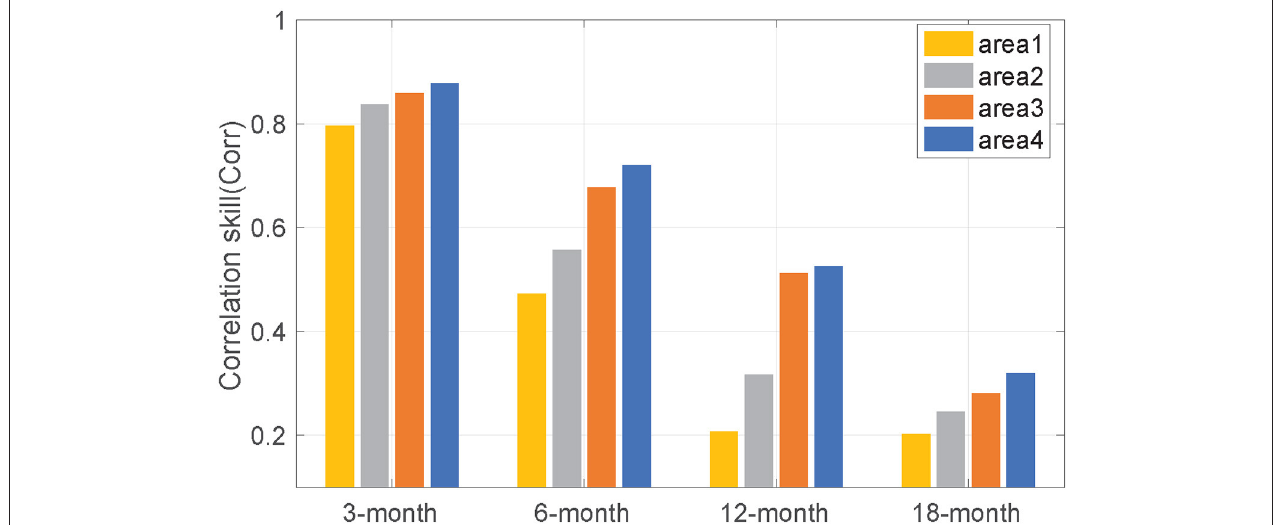
FIGURE 4 | The correlation skill (Corr) between predicted values and actual values with different input sizes. The different input size represents the different regional ranges: area1 (yellow) represents the Nino3.4 region (5 ◦ S–5 ◦ N, 170 ◦ W–120 ◦ W), area2 (gray) represents the region of (15 ◦ S–15 ◦ N, 170 ◦ E–100 ◦ W), area3 (orange) represents the region of (30 ◦ S–30 ◦ N, 125 ◦ E–55 ◦ W), and area4 (blue) represents the region of (55 ◦ S–60 ◦ N, 0 ◦ E–360 ◦ E).